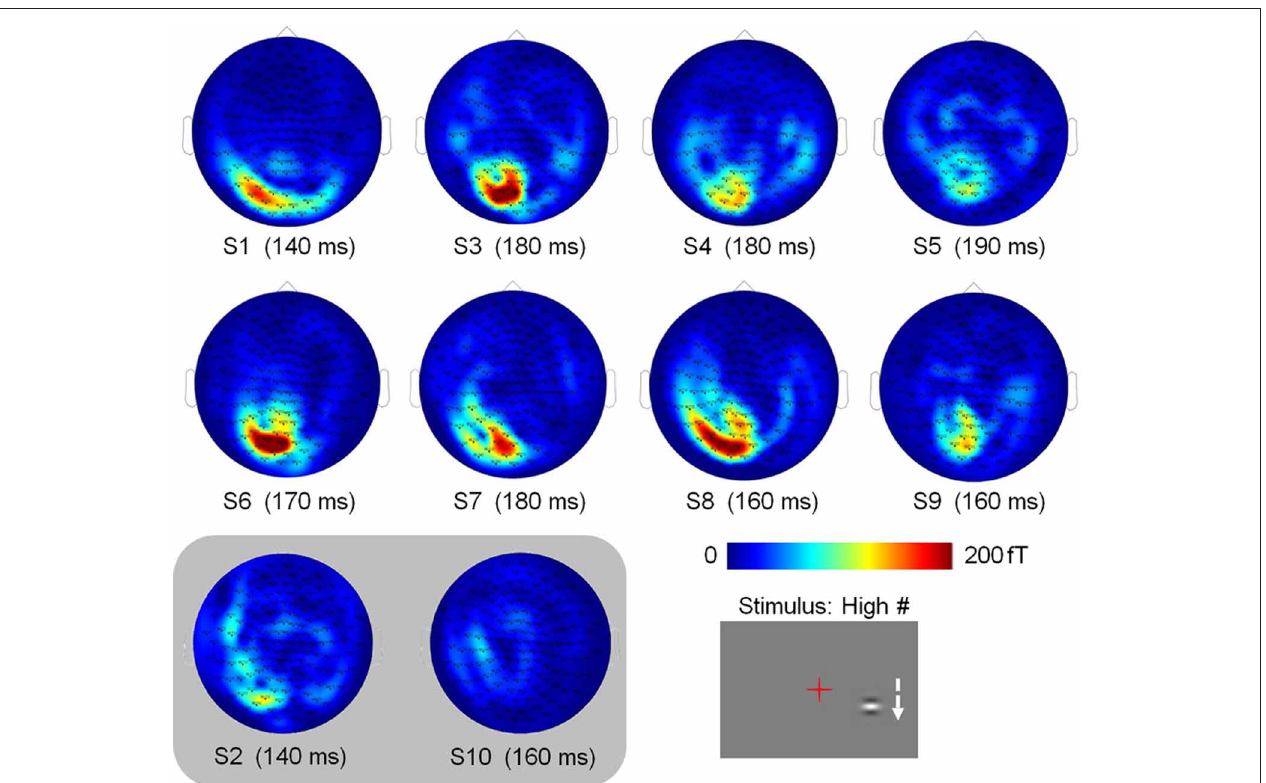
FIGURE 3 | Individual subject sensor topographies of the first peak of activity elicited by the High # condition, for the right stimulation (times indicated below). Activity is consistently located in the left hemisphere.